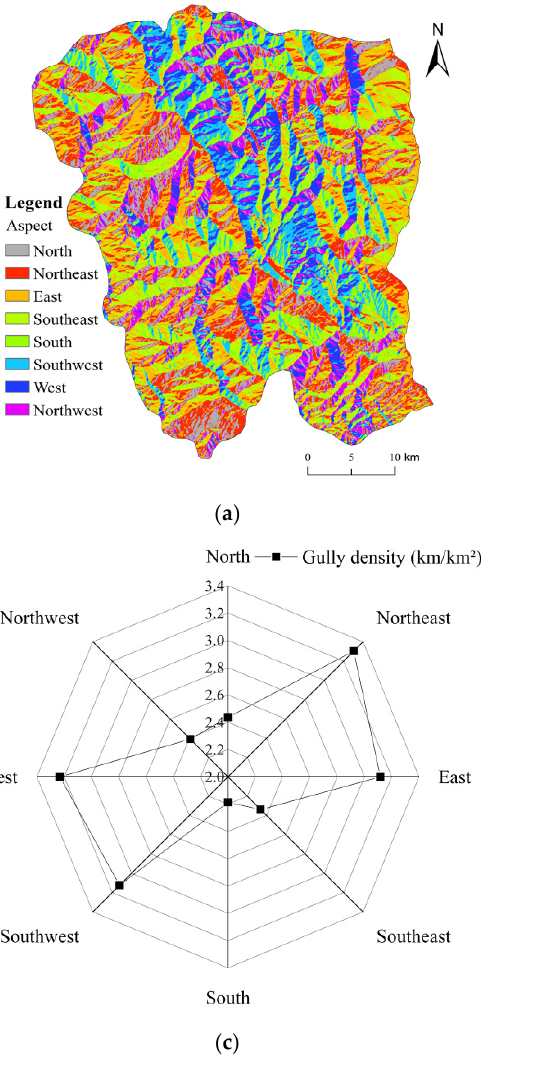
Figure 6. ( a ) Distribution of aspects; Characteristics of gully system parameters (gully length, density, and frequency) under different aspects: ( b ) Gully length; ( c ) Gully density; ( d ) Gully frequency. It reflects the distribution of gully parameters in different aspects.